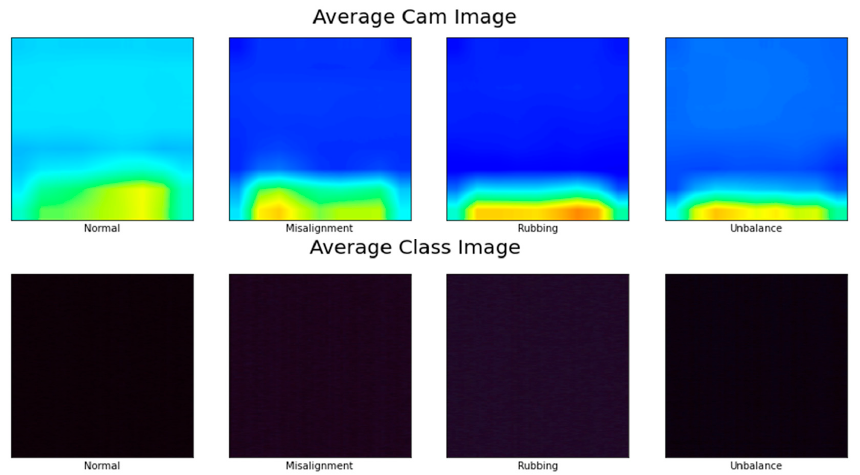
Figure 10. Visualization result of CAM ( Up ) and image average ( Down ) for each class derived from the model learned in this